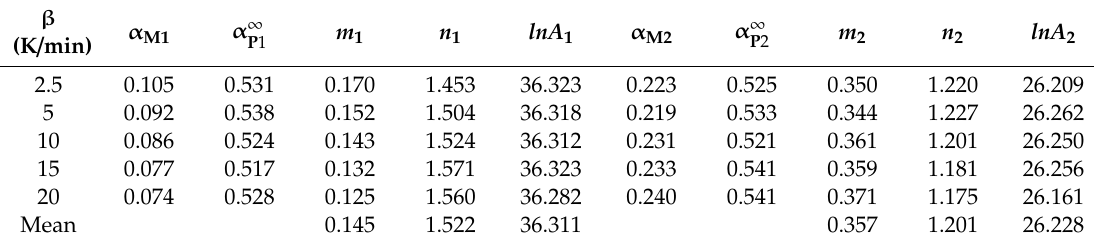
Table 3. The kinetic parameters calculated for the P-ddm / APbPc curing system.